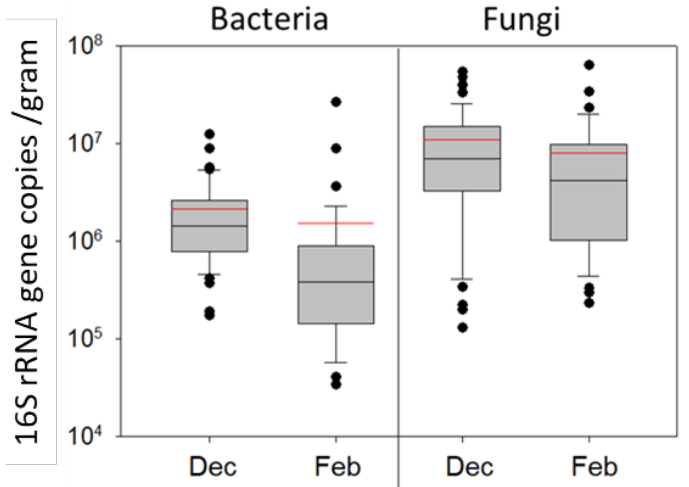
Figure 5. Abundance of bacteria and fungi in beebread calculated with qPCR of the rRNA gene and plasmid standards. Results display 80 beebread cells sampled from eight colonies on the seventh of December (Dec) and again on the eighth of February (Feb). Box plots display the variation in microbial abundance. The red line is the mean, black the median, boxes are at 25% and 75%, whiskers at 5% and 95%, and dots are outliers. Comparing log-transformed 16S rRNA gene copy number estimates, bacterial load decreased significantly overwinter (t 80 = 4.9, p < 0.00001), but fungal load remained similar (t 80 = 1.5, p =